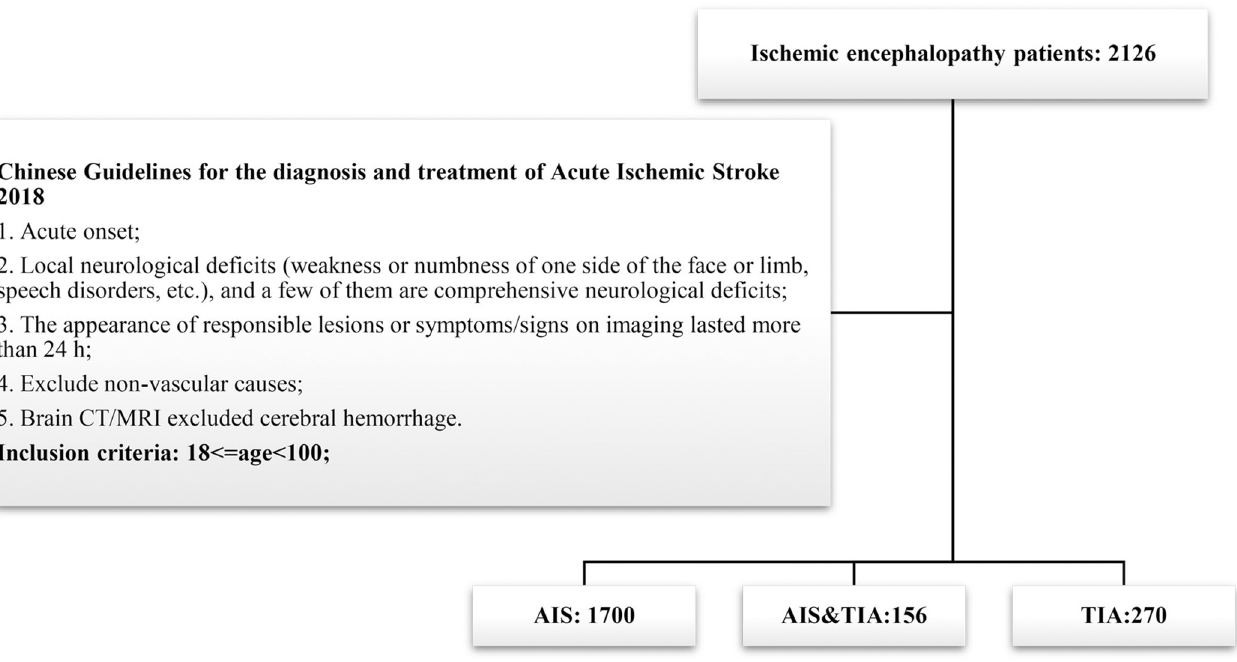
Fig 1. The screening process of AIS patient